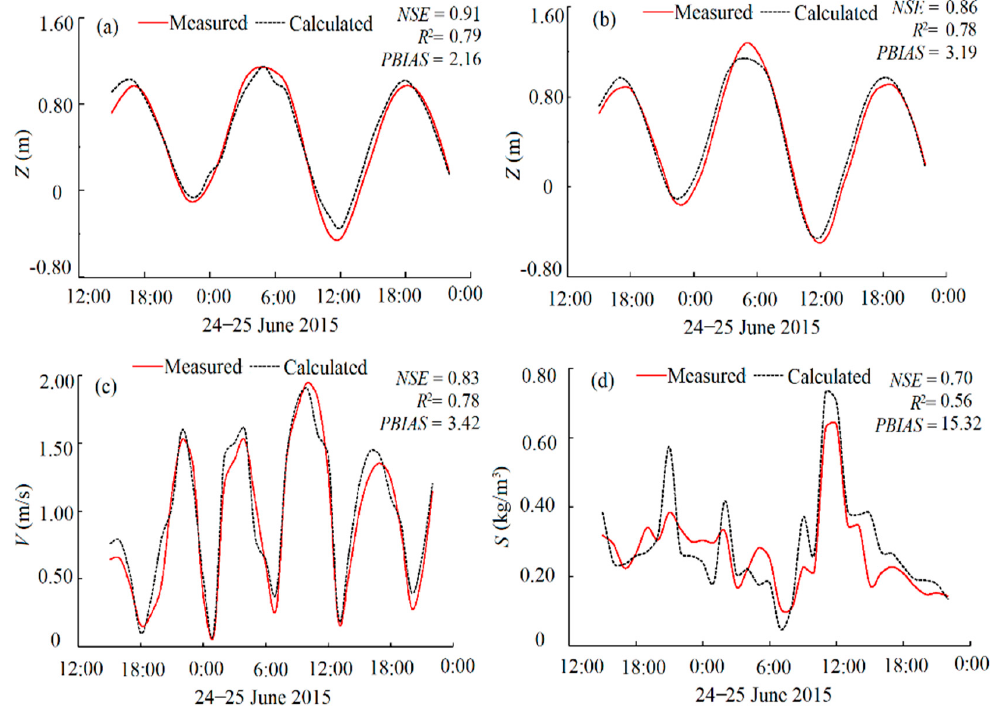
Figure 10. Model validation with the neap tide (June 2015): ( a ) Z at WL4; ( b ) Z at WL5; ( c ) V at FS4; ( d ) S at FS4.